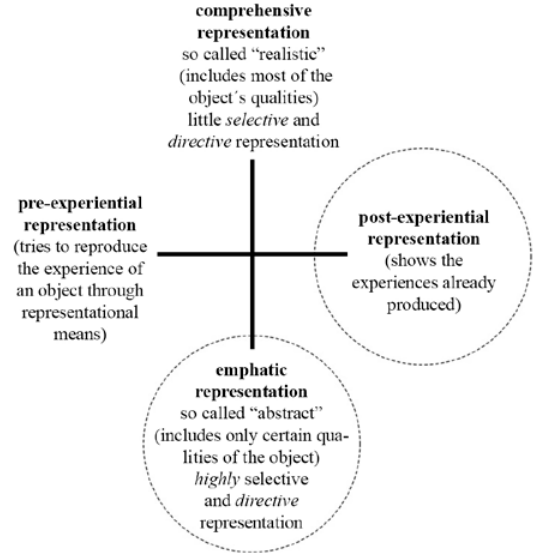
fig. 13. Dichotomies discussed in this chapter and the previous one; the categories on which this article has focused appear encircled.